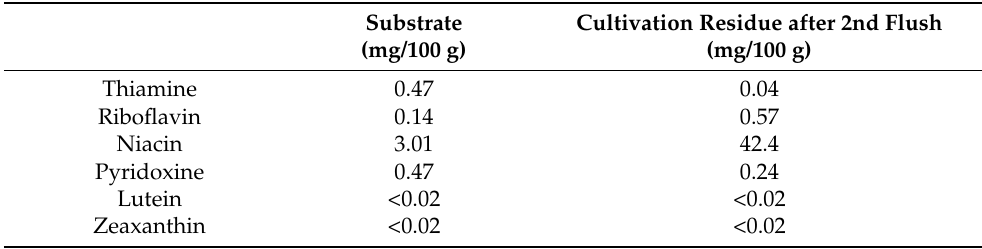
Table 2. Selected vitamin Bs, lutein and zeaxanthin in the initial substrate and cultivation residue after harvesting the second flush of oyster